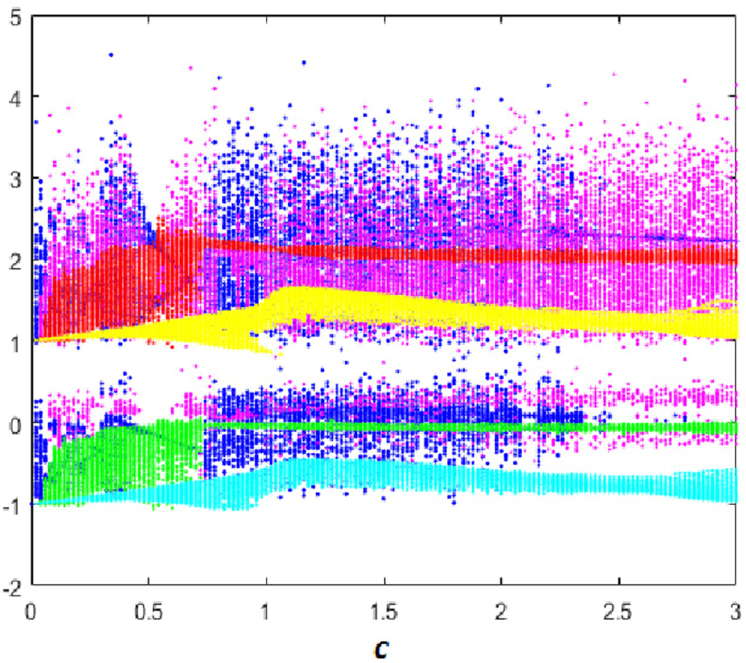
Fig 15. Bifurcation diagram of system (1) versus c starting from: ξ 1 (blue), ξ 2 (red), ξ 3 (green), ξ 4 (magenta), ξ 5 (yellow) and ξ 6